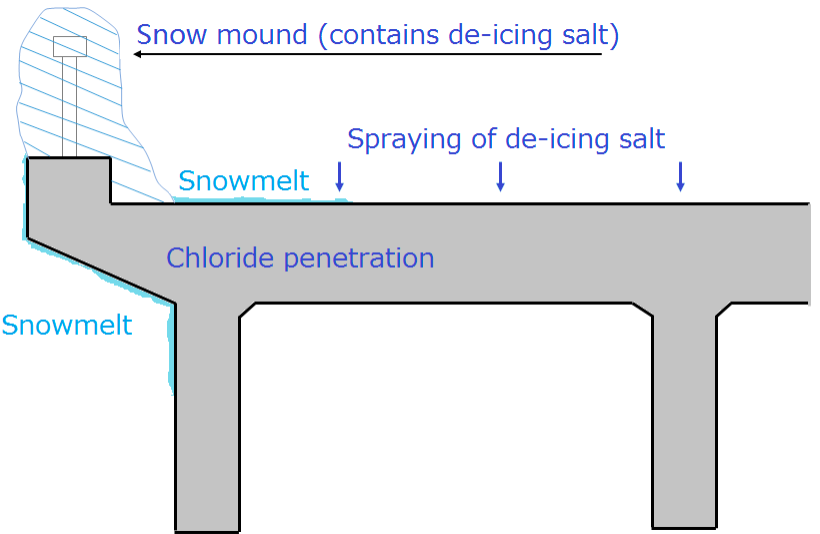
Figure 9. Mechanism of salt damage for slabs in East Japan.